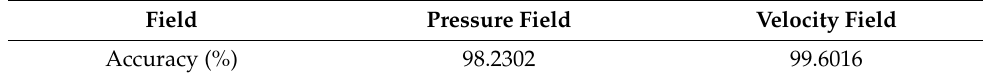
Table 4. Mean accuracy of the physical field prediction for the test data.